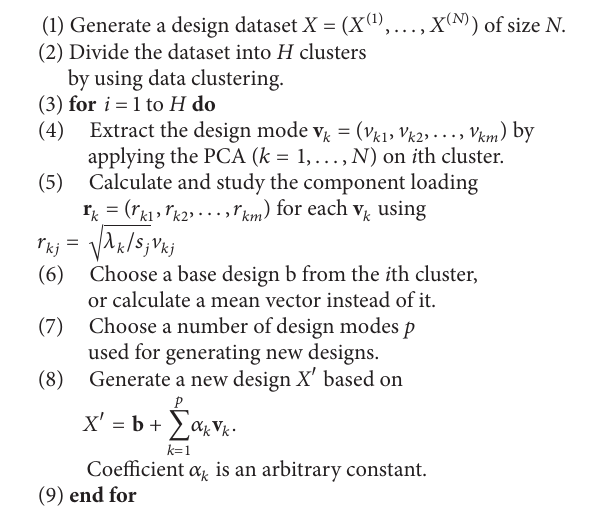
Algorithm 1: Design mode analysis.